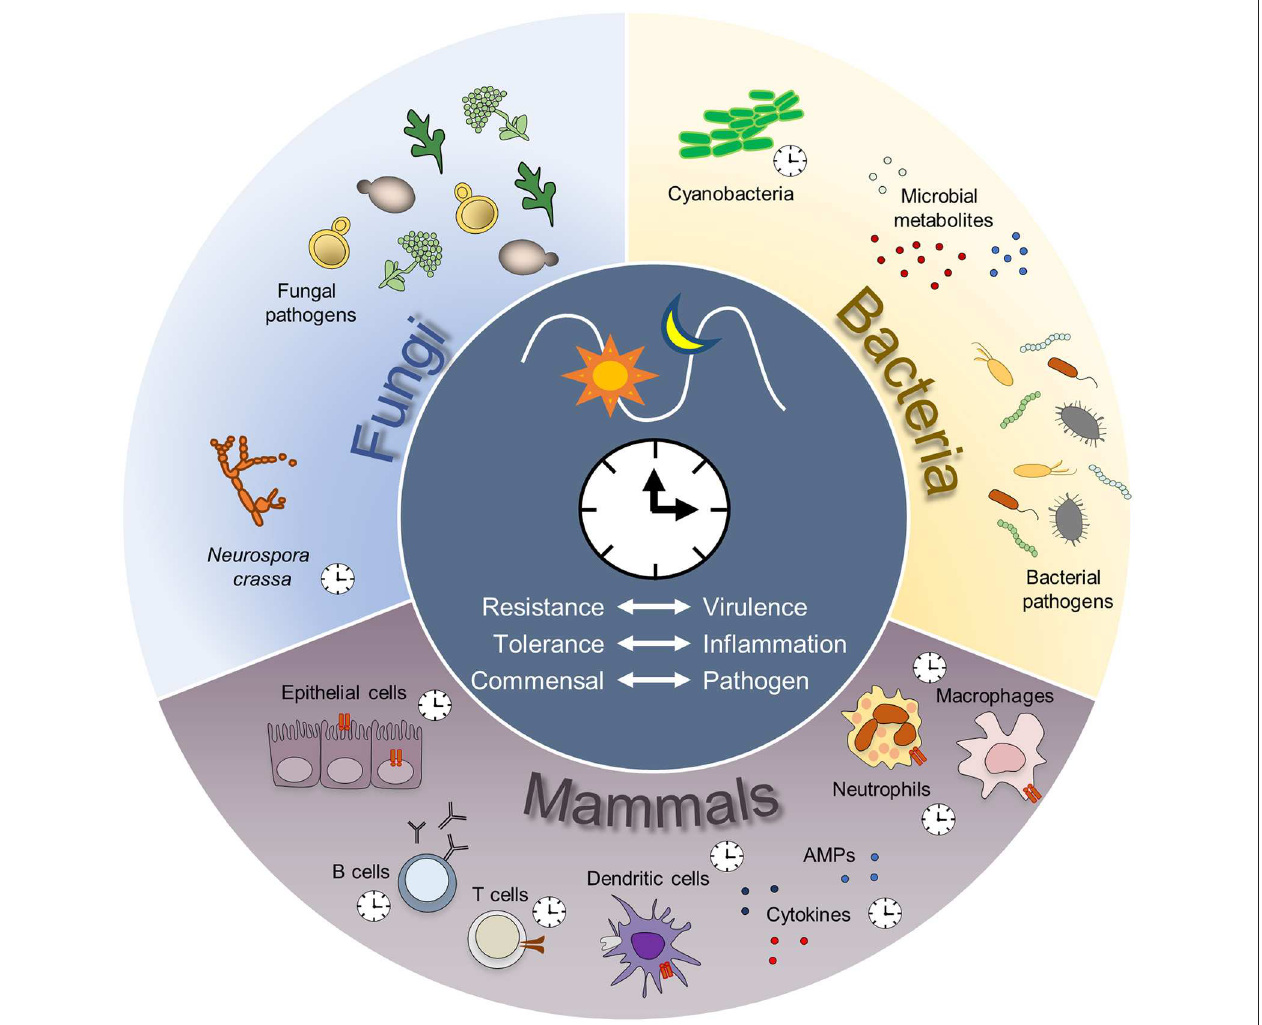
FIGURE 2 | Host-microbes circadian interactions. A circadian control of antimicrobial immunity is largely documented. Endogenous circadian rhythms might exist also in bacterial and fungal species important for human health. Potential cross-talk between the clock machinery of each species might influence the balance between resistance of the host and virulence of the pathogen, leading to a time-dependent prevalence of inflammation or tolerance, ultimately defining the switch between commensal to pathogenic relationships. AMP, antimicrobial peptides.